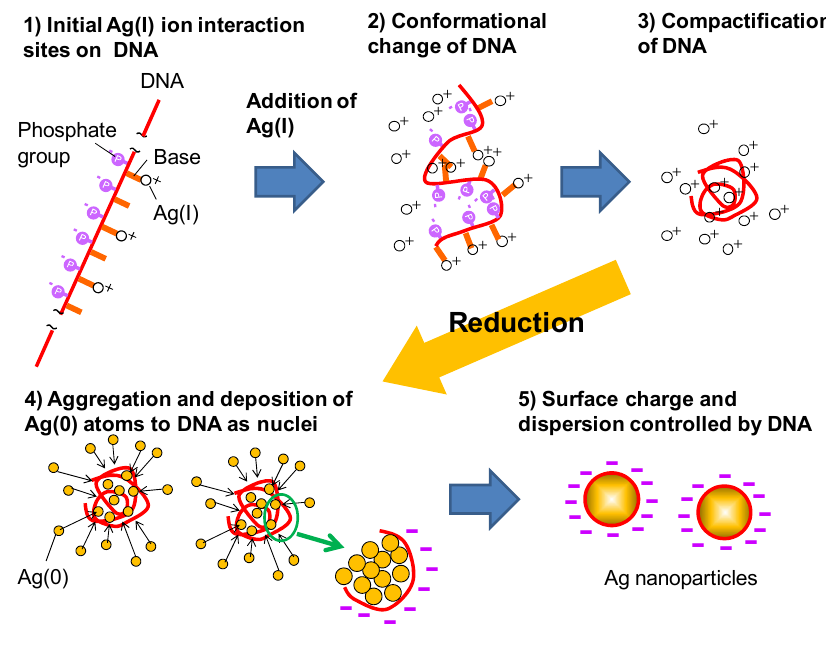
Figure 7. Proposed formation mechanism of the DNA/Ag